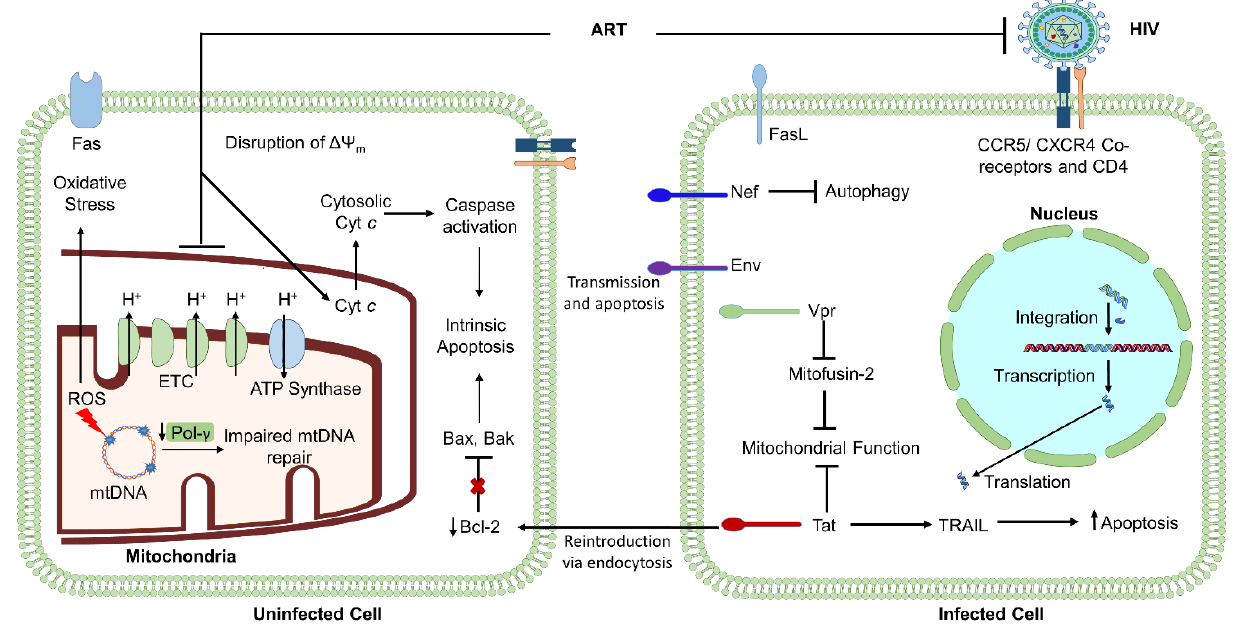
Figure 2. Model of cooperative induction of mitochondrial compromise by HIV-infection and ART-treatment. Mitochondrial dysfunction is mediated by viral integration, disruption of mitochondrial membrane potential ( ∆Ψ m), decreased respiration and ATP synthesis, mtDNA mutations, impaired mtDNA repair, intrinsic apoptosis, and oxidative stress. Collectively, these deregulations facilitate energetic failure and depletion of CD4 T cells.